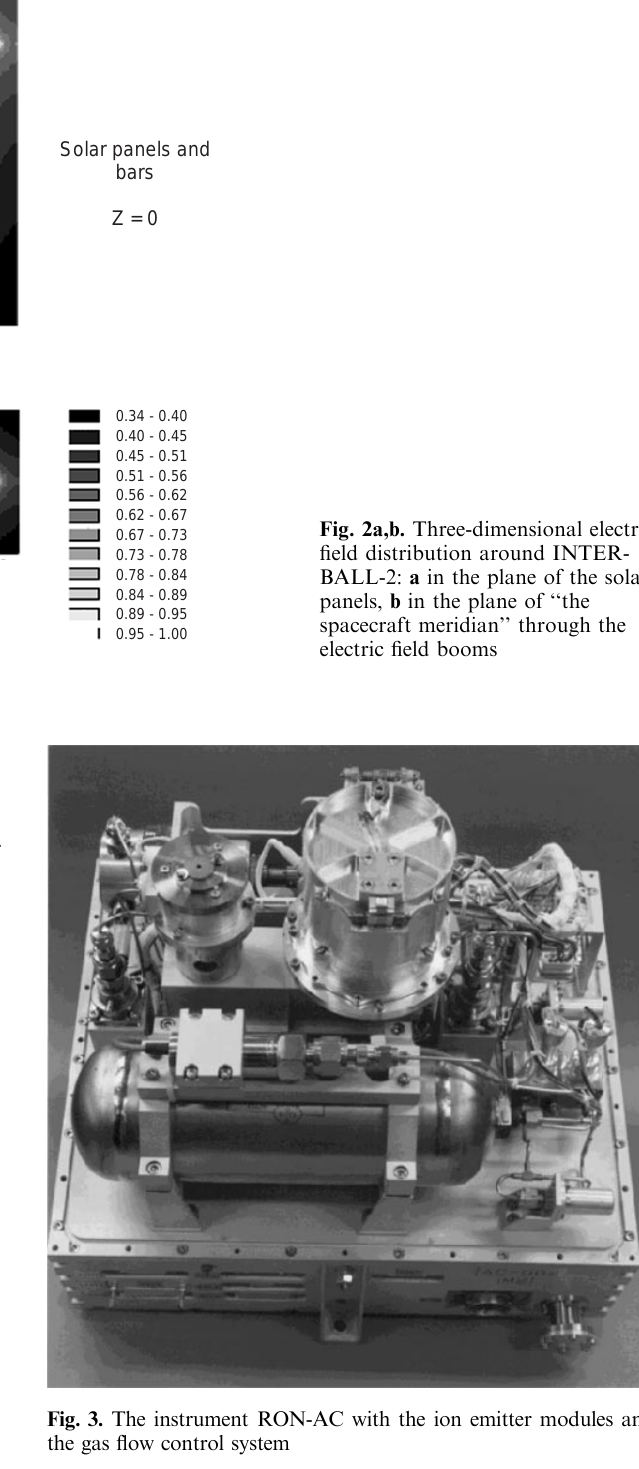
Fig. 3. The instrument RON-AC with the ion emitter modules and the gas flow